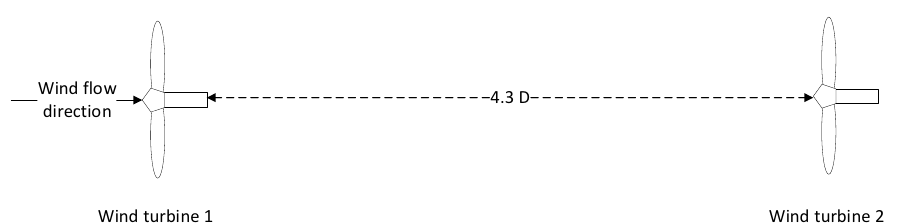
Figure 2. Layout of two-turbine array used for the testing of DFP.